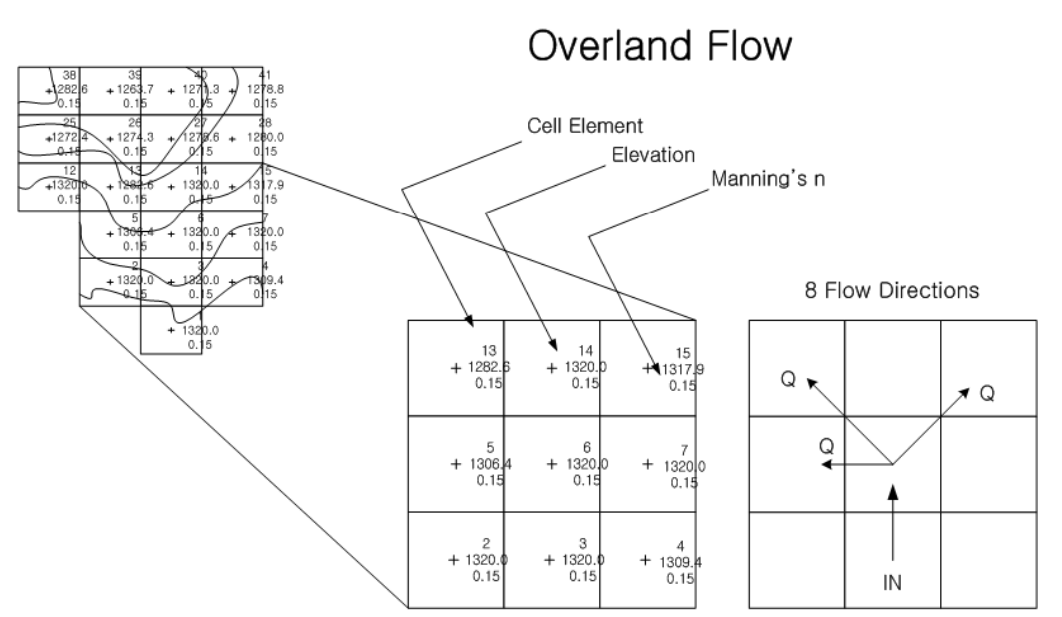
Figure 4. Discharge flux across cell element boundaries [34].